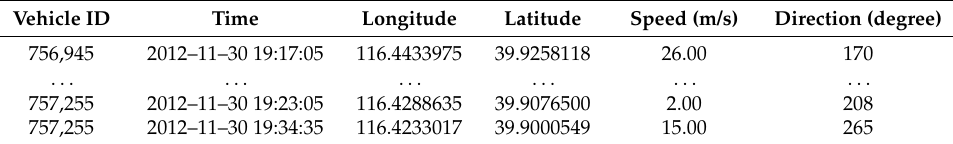
Table 2. Example of the global positioning system (GPS) trajectory